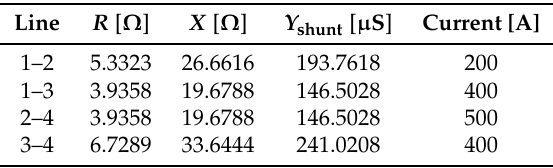
Table 6. Line parameters of the four-node test